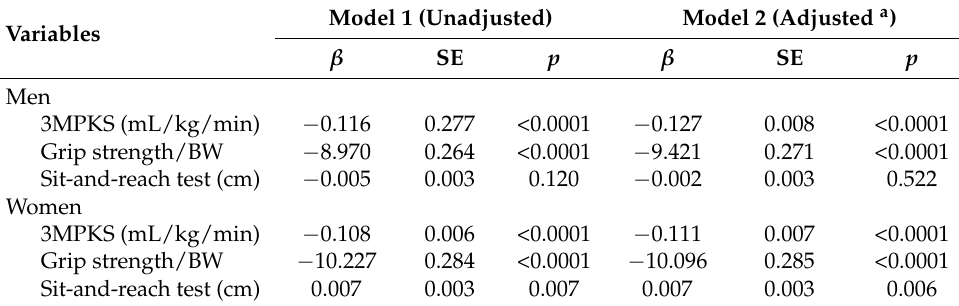
Table 3. Regression coefficients for predicting BMI using different scientific physical fitness measure-